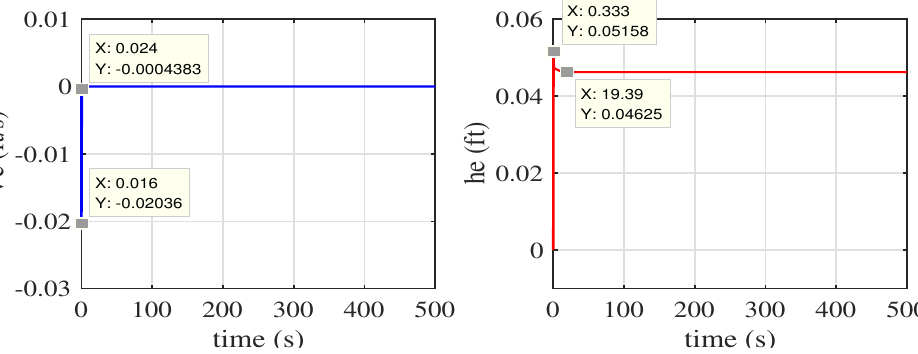
Figure 3. Velocity error and altitude error proposed by PID controller in horizontal flight and fault free state.